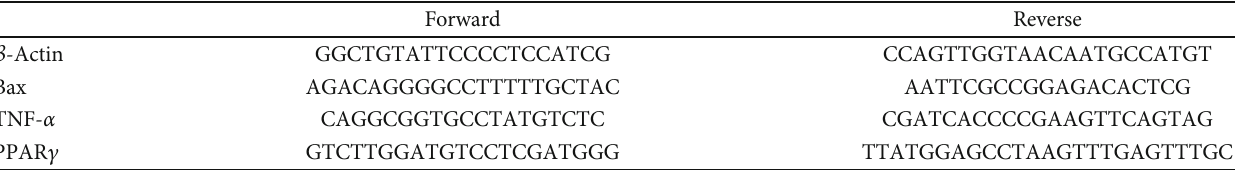
Table 1: Sequences of primer pairs used for ampli fi cation of mRNA by real-time